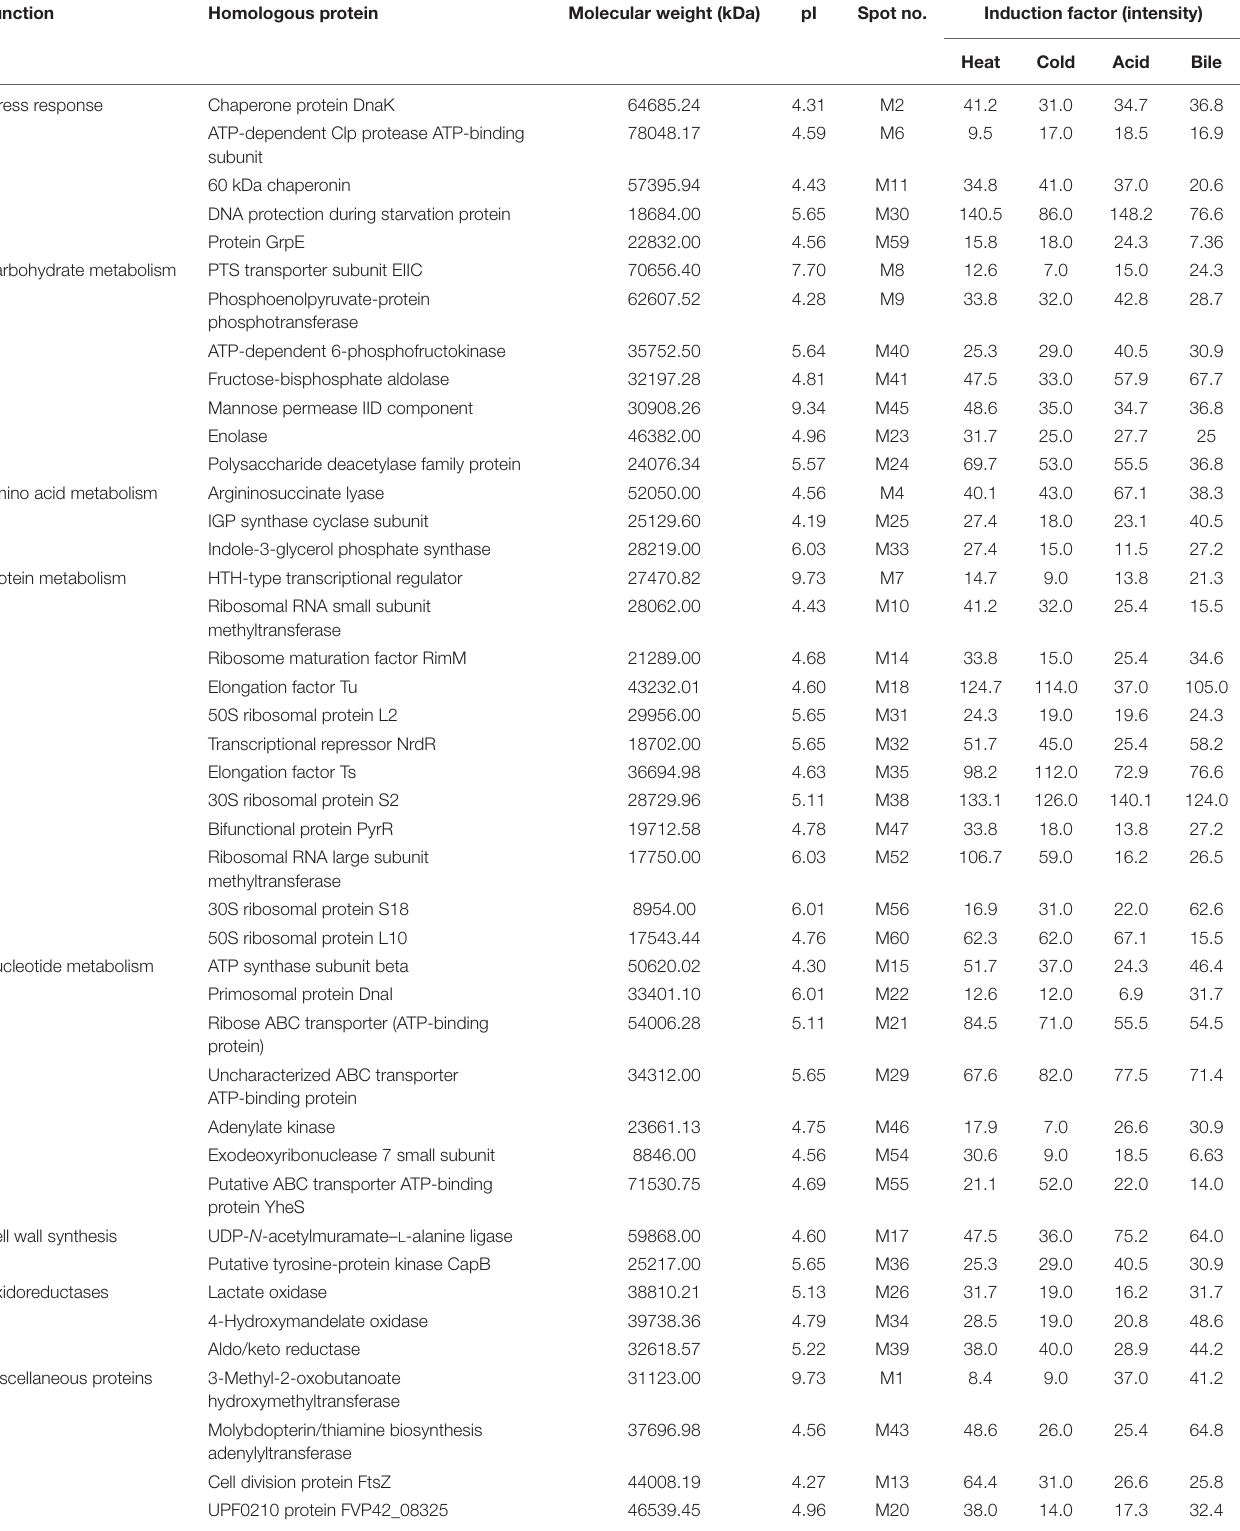
TABLE 1 | Identified proteins in P. pentosaceus M41 with their molecular weight, pI values, protein spot intensities under heat, cold, acid, and bile stresses. Function Homologous protein Molecular weight (kDa) Spot